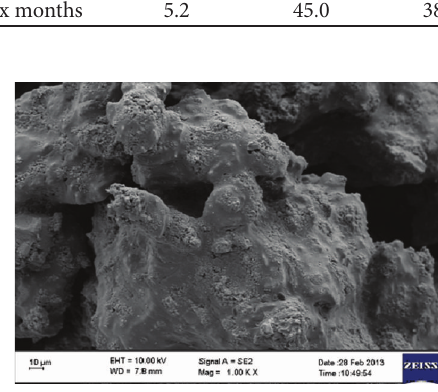
Figure 5: SEM image of ammonium nitrate with 1mL H 4 SiO 4 /5.6 mL H 2 SO 4 .